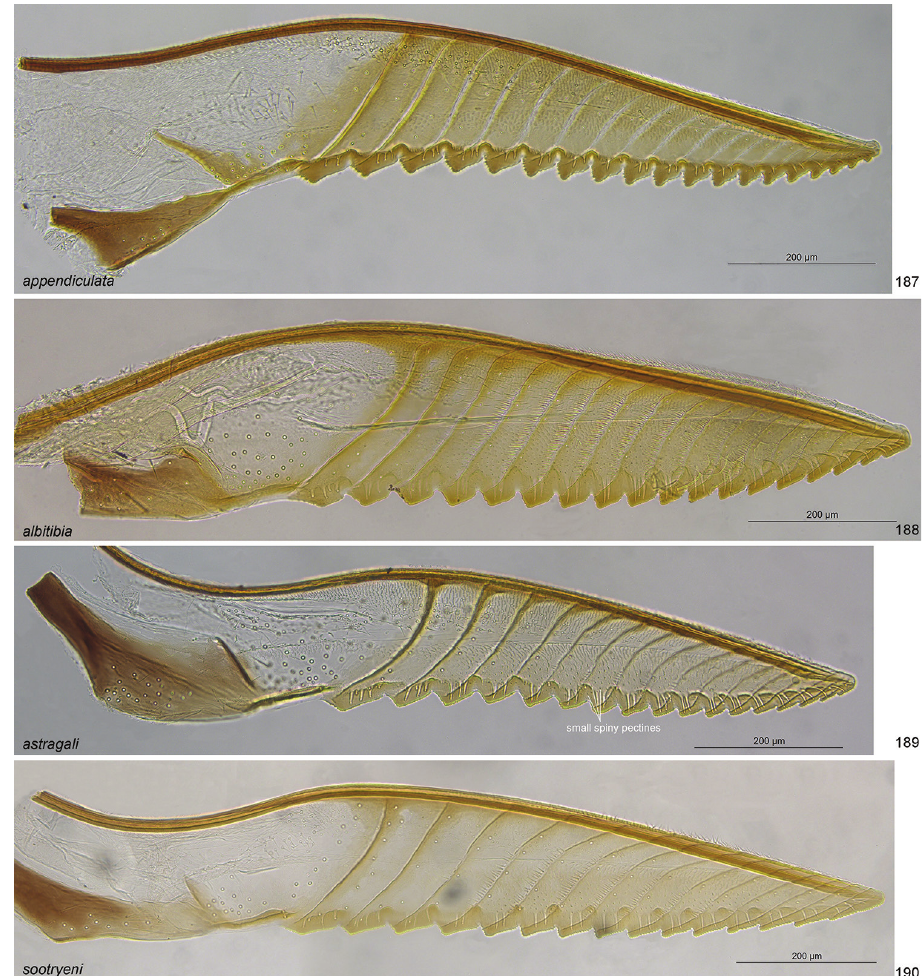
Figures 187–190. Lancets of Pristiphora . 187 appendiculata DEI-GISHym21073 188 albitibia DEI- GISHym20944 189 astragali DEI-GISHym80042 190 sootryeni